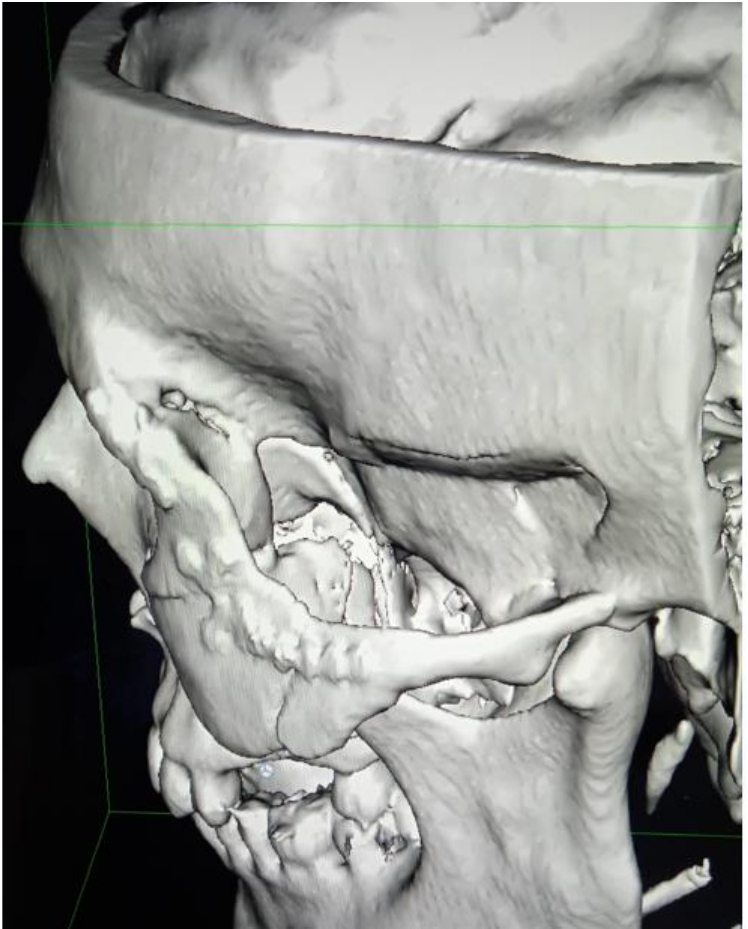
Figure 13. Postoperative 3D-CT reconstruction after stable bone osteosynthesis. After fracture reduction and stable osteosynthesis, no zygomatic bone-coronoid process of the mandible conflict was present.